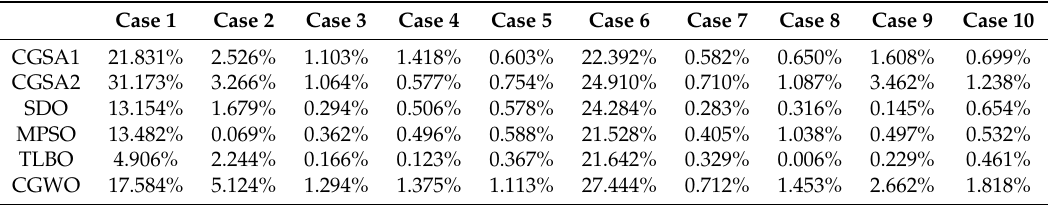
Table 7. Improvement of objective functions of GROM over other